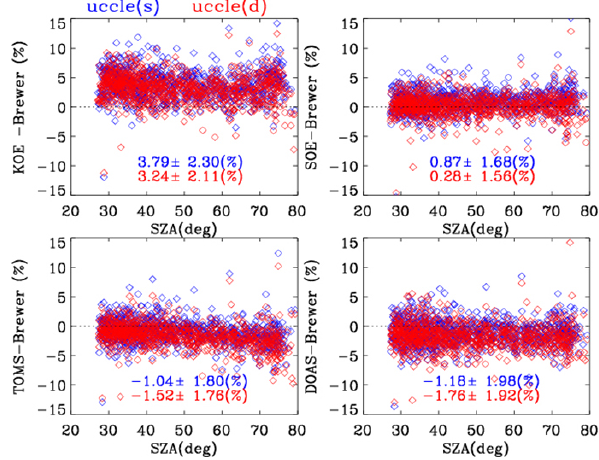
Figure 3. Comparison between OMI and Brewer total ozone mea- surements as a function of solar zenith angle at Uccle station with single (blue) and double (red) Brewer instruments, respectively. The mean relative biases and 1 σ standard deviations are shown in the